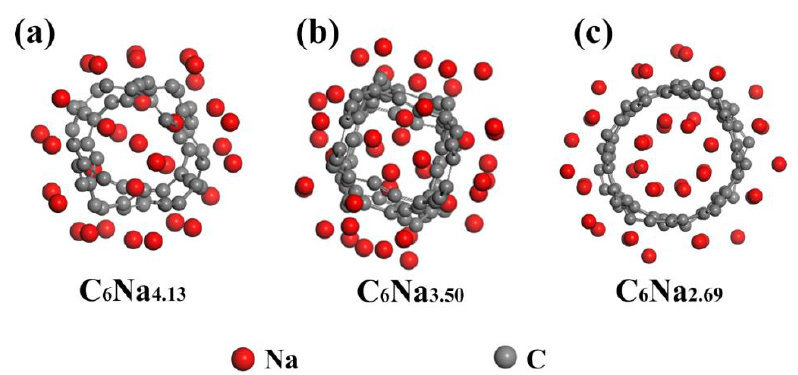
Figure 5. Optimized geometries with maximum storage capacity of ( a ) (3, 0)- α GyNT, ( b ) (2, 0)- βGyNT and ( c ) (4, 0)- γ